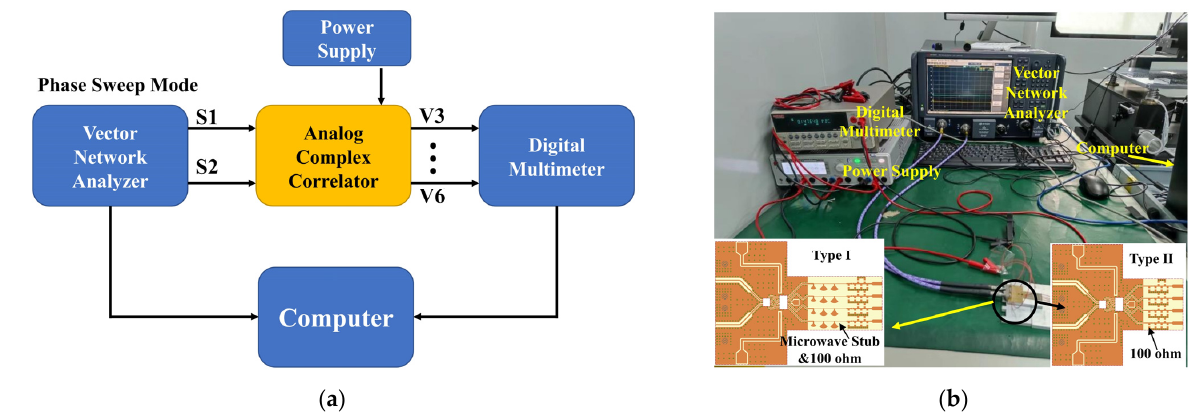
Figure 12. The test setup and measurement site of the correlator: ( a ) The test setup of the correlator; ( b ) The measurement site of the correlator.